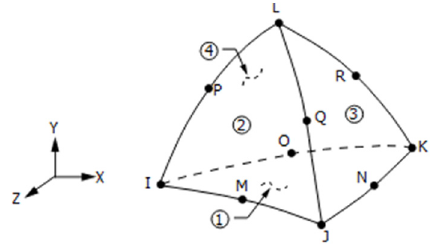
Figure 8. SOLID 187 geometry.